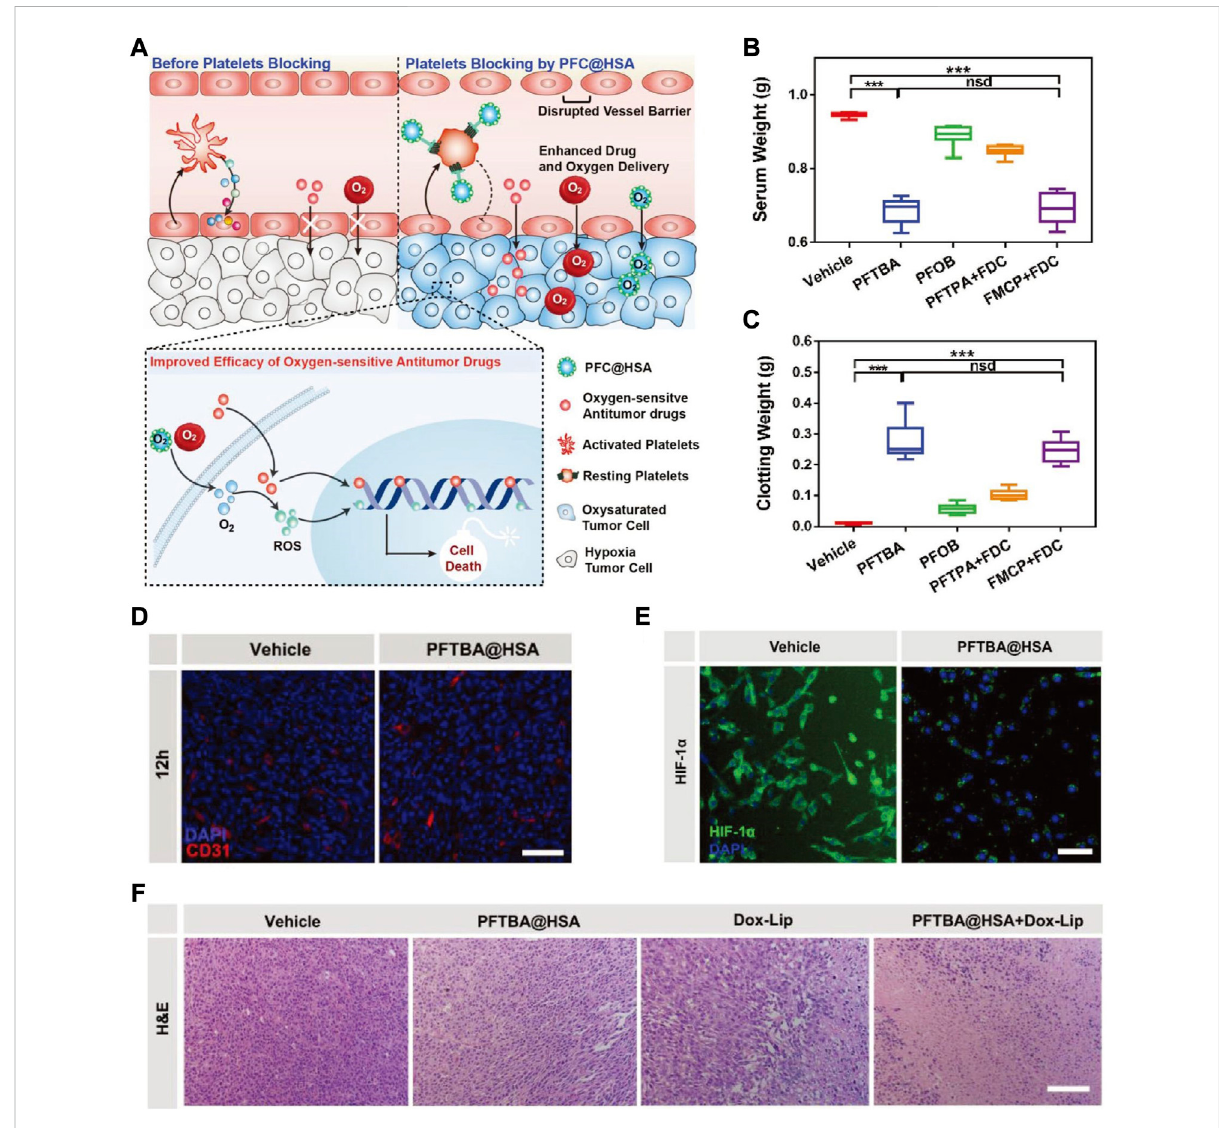
FIGURE 2 (A) The scheme showing PFTBA@HSA mediated platelet blocking for improved ef fi cacy of oxygen-sensitive antitumor drugs. (B,C) Quanti fi cationofserumweight (B) andclottingweight (C) . (D) Representativeimmuno fl uorescenceimagesofCD31stainingtodepicttumorvessels (scale bar = 50 μ m). (E) Representative immuno fl uorescence images of HIF-1 α staining to track the degree of tumor hypoxia. (F) Representative images of H&E staining of the tumor tissues after indicated treatments (scale bar = 100 μ m). Statistical signi fi cance was calculated by two-tail Student ’ st-test.* p < 0.05;** p < 0.01;*** p < 0.001.Reprocessedwithpermissionfromref53.Copyright2018,WILEY-VCHVerlagGmbH&Co.KGaA,